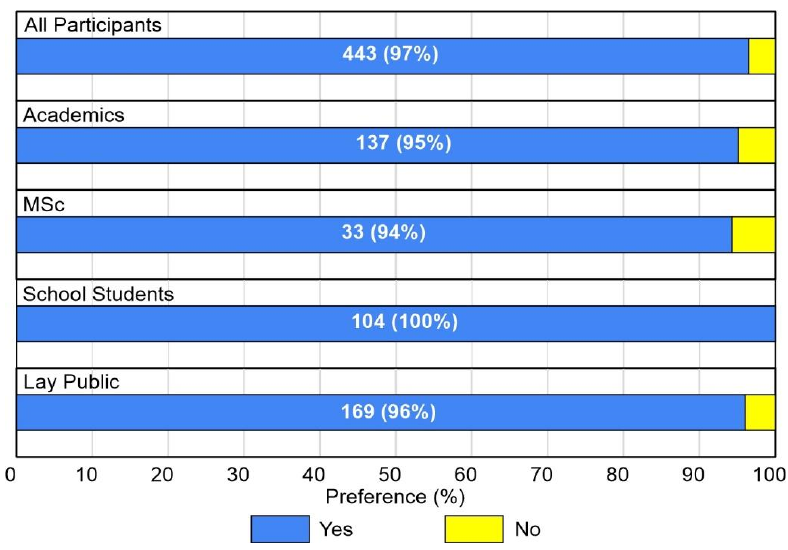
Figure 12. Bar charts showing the participants’ wish to repeat the immersive virtual reality exploration experience. The results represent both the total number of participants and the background of each group respectively.